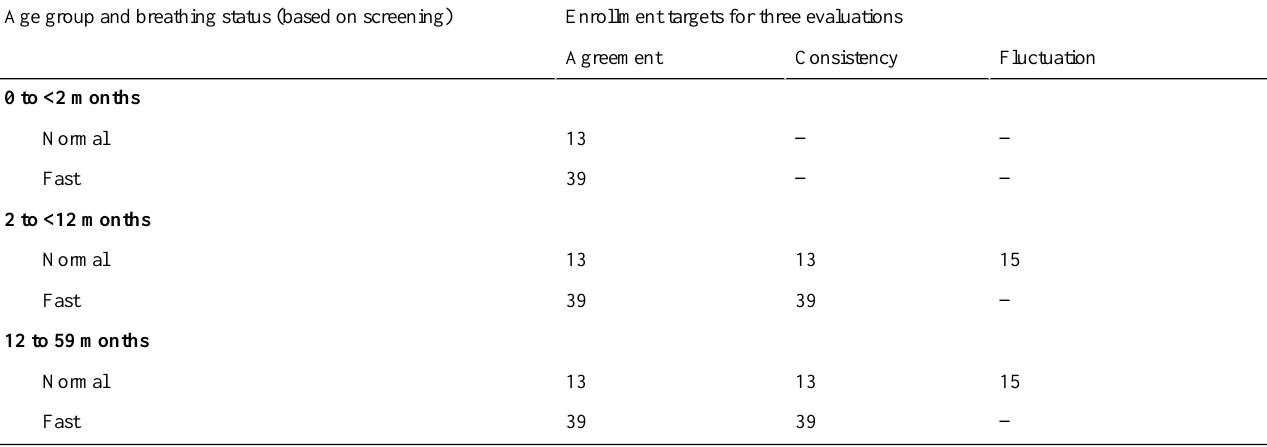
Table 2. Enrollment targets for each type of evaluation by age group and breathing status.